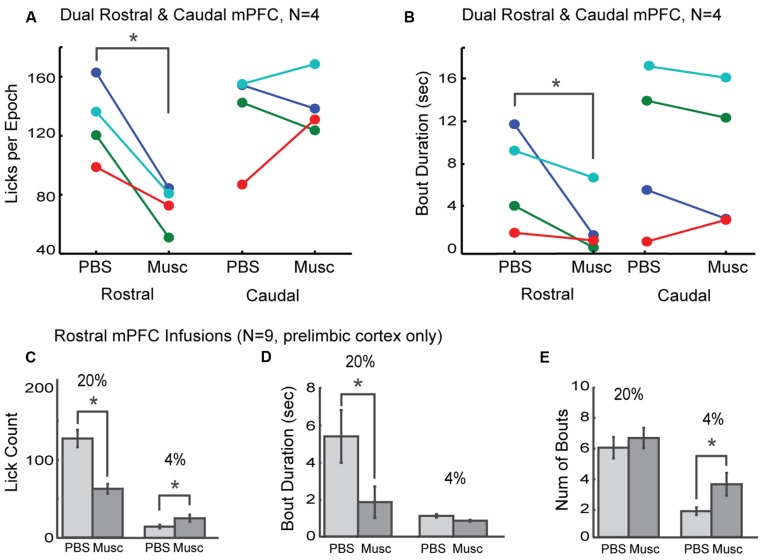
Effects of inactivation on measures of incentive contrast were specific to the rostral mPFC. (A) Inactivation of the rostral, but not the caudal, mPFC reduced licking for the higher value fluid. (B) Inactivations also reduced bout durations following rostral mPFC inactivation. No effects of caudal mPFC inactivation were found for any measure of licking microstructure, including bout duration. These data were collected in four rats with dual bilateral cannula (blue and red dots in Figure 3A). (C) Inactivation of rostral mPFC in nine rats (see cannula locations in Figure 3A) decreased licking for the high value (20%) sucrose and increased consumption of low value (4%) sucrose. (D) Bout duration for high, but not low, value sucrose was also reduced following inactivation. (E) There was no change in the number of licking bouts for the high value sucrose. However, more bouts were emitted when the low value fluid was available and the rostral mPFC was inactivated. *p < 0.05.